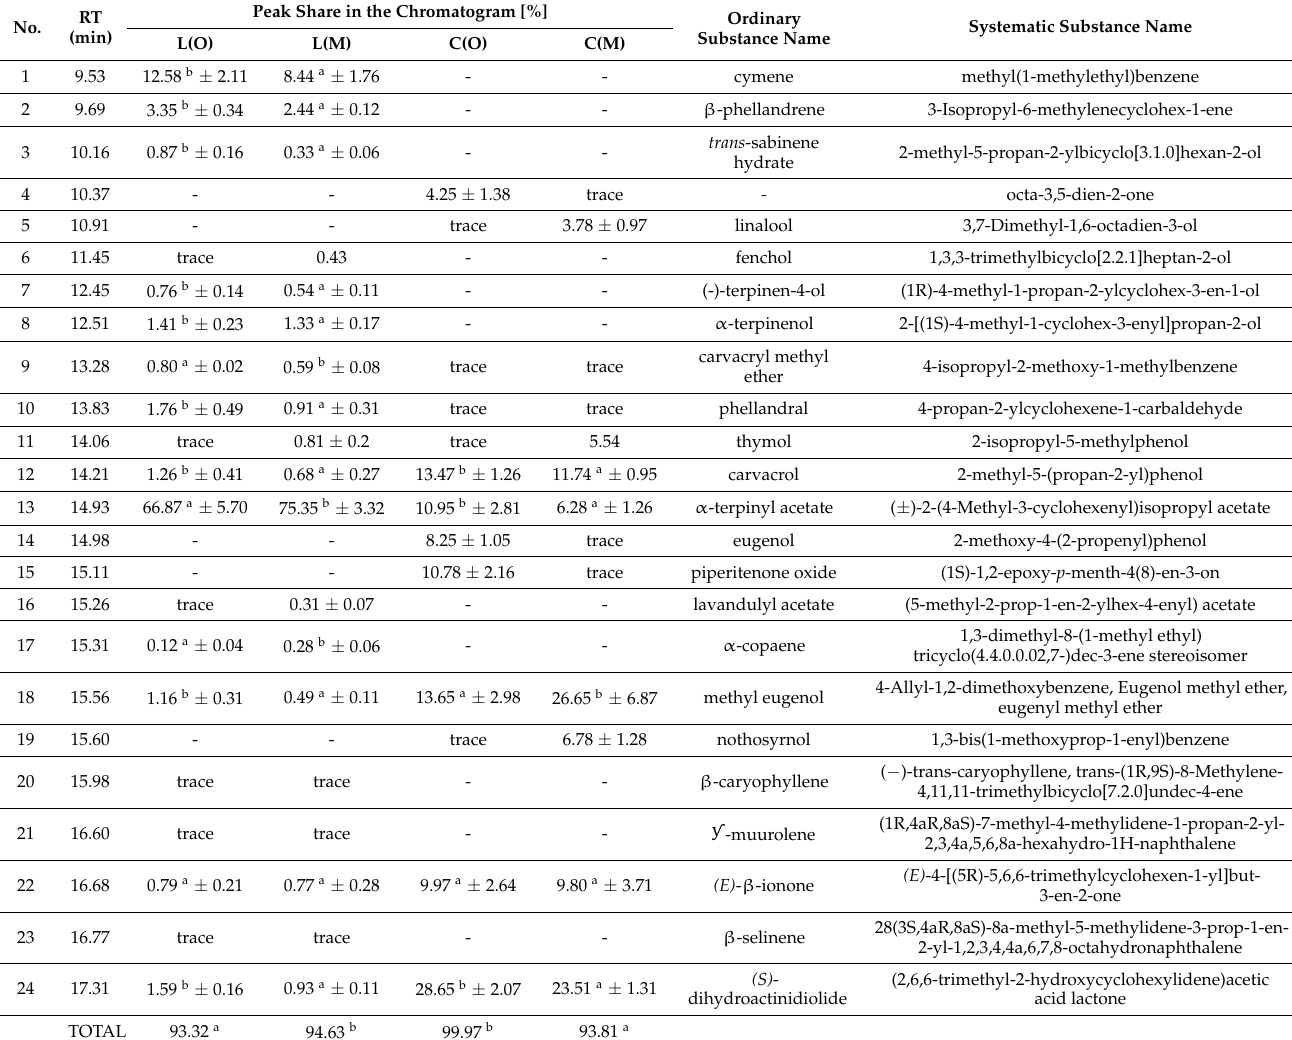
Table 2. Effect of the applied fertiliser on the chemical composition of headspace fractions of dry leaves of Coriandrum sativum L. and Levisticum